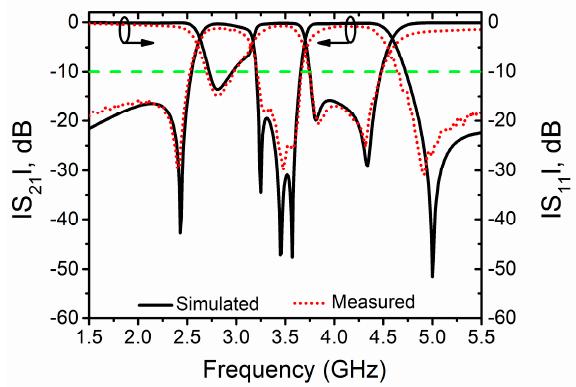
Figure 10. Filter responses of Case E ( C F = 4.8 pF, C S = 6.2 pF, C T = 100 pF).